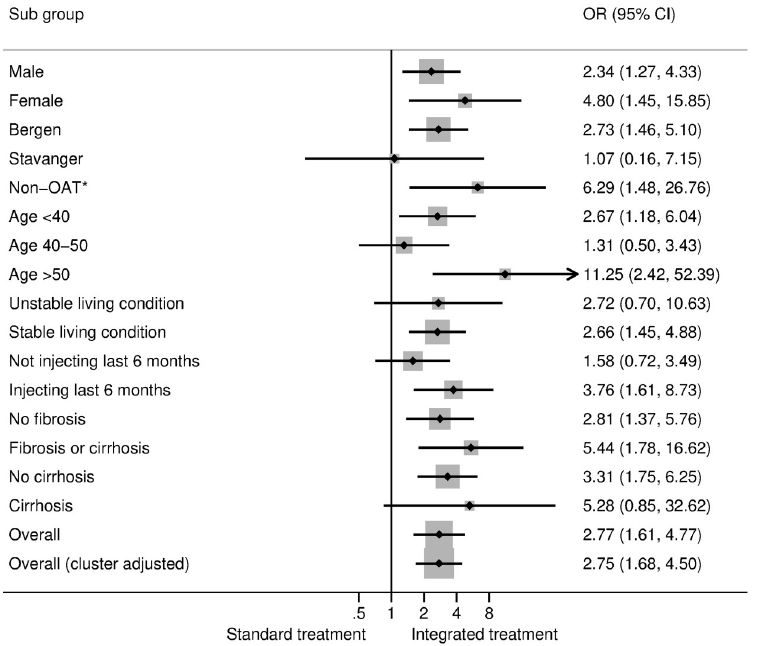
Fig 4. Subgroup analyses for binomial logit regression of SVR of hepatitis C for all who were randomized comparing the integrated arm with the standard arm (post hoc ITT analyses). Subgroup effects are presented for gender, the type of treatment center, age group, living condition, injecting drug use behavior the last 6 months, fibrosis and cirrhosis, and overall effects (without and with cluster adjustment) �� . � Non-OAT: patients who did not receive OAT. �� Interaction tests: sex: p = 0.231, site: p = 0.358, OAT/non-OAT: p = 0.237, age: p = 0.041, living condition: p = 0.928, injecting drugs: p = 0.972, fibrosis/cirrhosis: p = 0.382. ITT, intention-to-treat; OAT, opioid agonist therapy; OR, odds ratio; SVR, sustained virologic response.